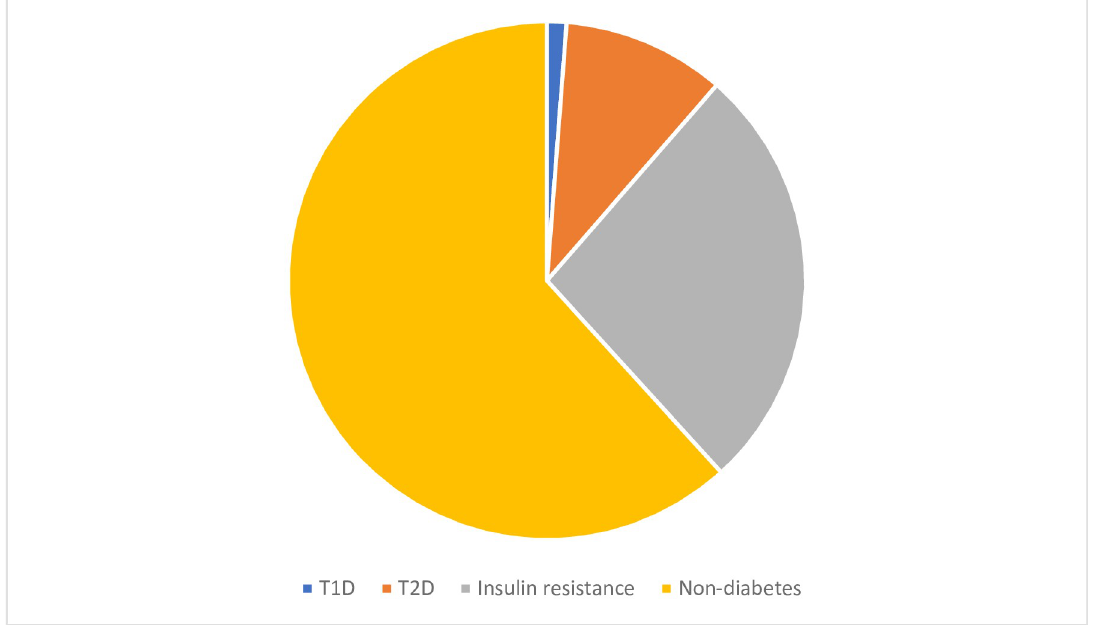
Fig 1. Proportions of T1D, T2D and insulin resistance in the cross-sectional analysis at baseline (n = 570).